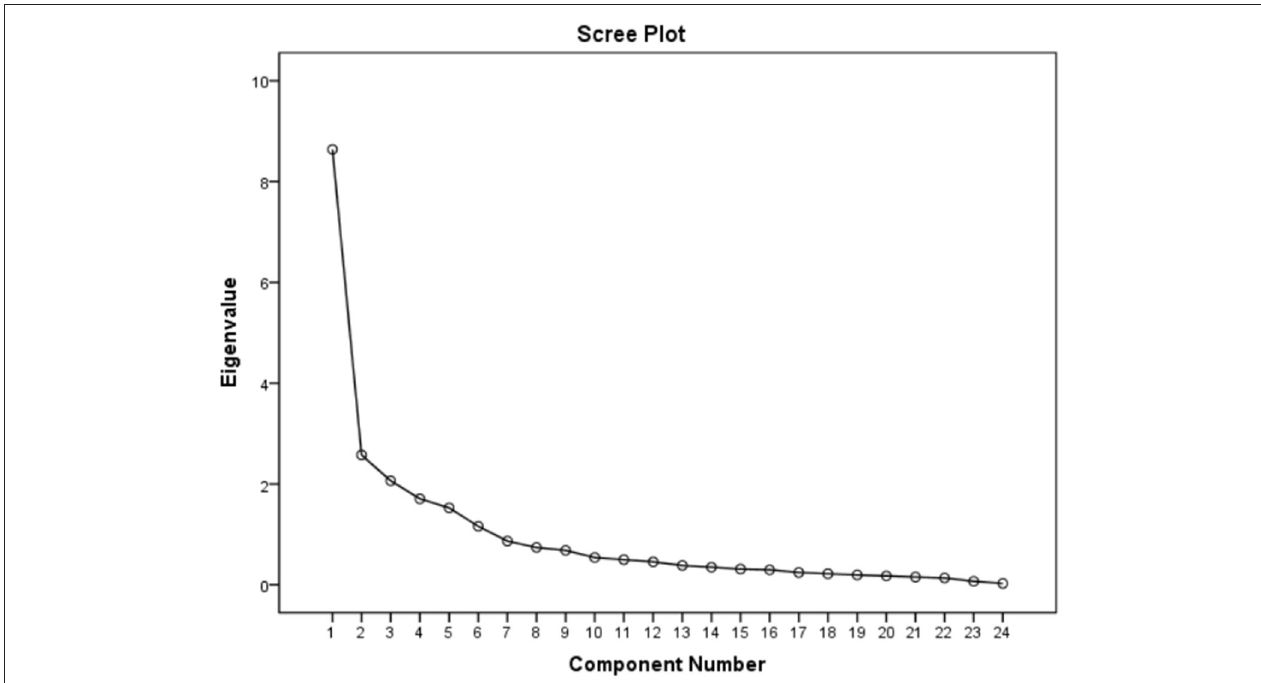
FIGURE 3 | Screen plot of exploratory factor analysis for Chinese version of the